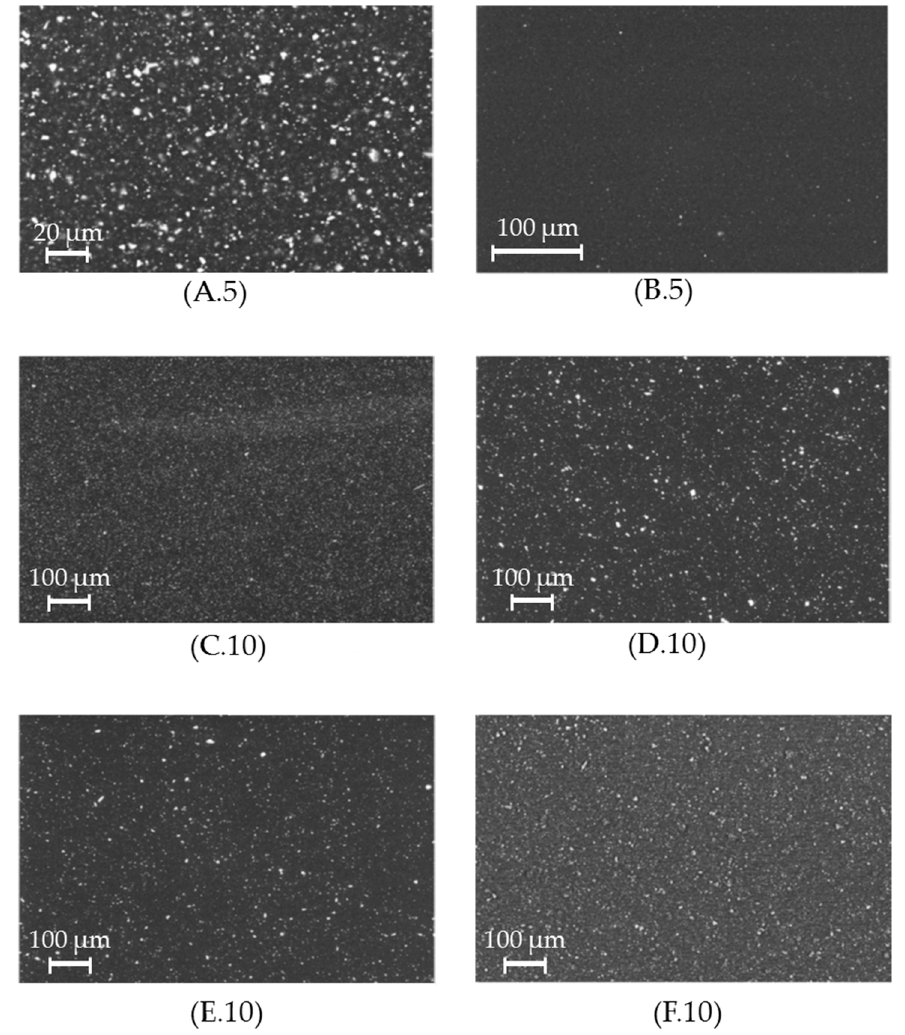
Figure 4. SEM images of the filler distribution within the polyamide 12-CaCO 3 composites: A.5; B.5; C.10; D.10; E.10; F.10 (from left up to right